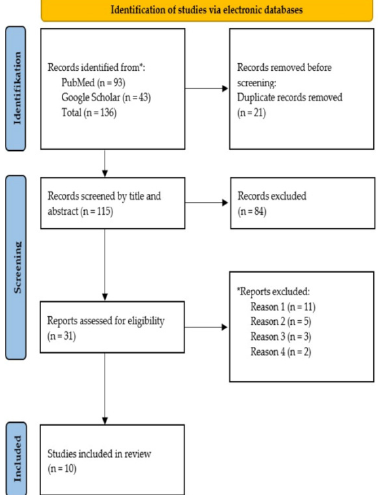
Figure 1. Flow diagram (Preferred Reporting Items for Systematic Reviews and Meta-Analyses— PRISMA) of the study inclusion process. * Reports excluded: Reason 1: no or inadequate focus on management of burn units during the COVID-19 pandemic; Reason 2: not considered to be original quantitative research; Reason 3: unavailable in the English language; Reason 4: irretrievable. The respective studies originated in Graz, Austria [6]; Chongqing, China [7]; Chelms- ford, UK [8]; Rabat, Morocco [9]; Barcelona, Spain; Singapore, Singapore; Torino, Italy; Iowa City and Seattle, USA; Chongqing and Shanghai, China; Birmingham, UK; Tokyo, Japan [10]; Petah Tikva, Israel [11]; Shanghai, China [12]; Johannesburg, Cape Town, Kim- berley, and Durban, South Africa [13]; and Delhi, India [14,15]. A brief overview of the included studies and their key points is mentioned in Table 2.